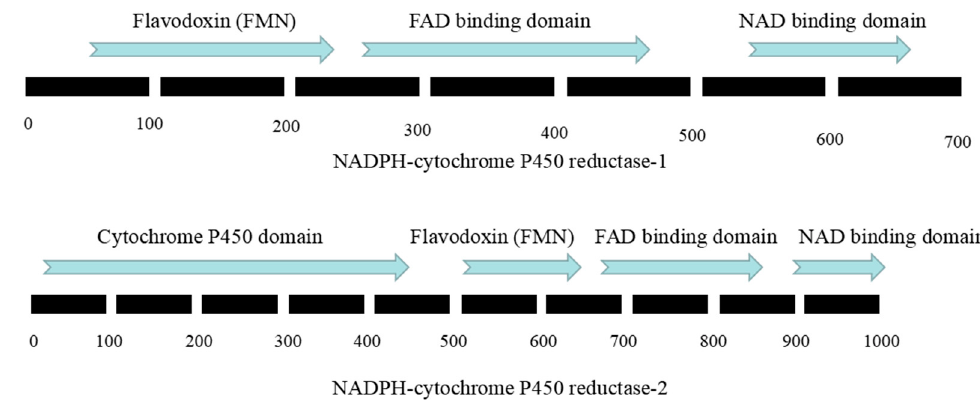
Figure 7. Amino acid sequence domains of NADPH-cytochrome P450 reductases of O. sinensis.